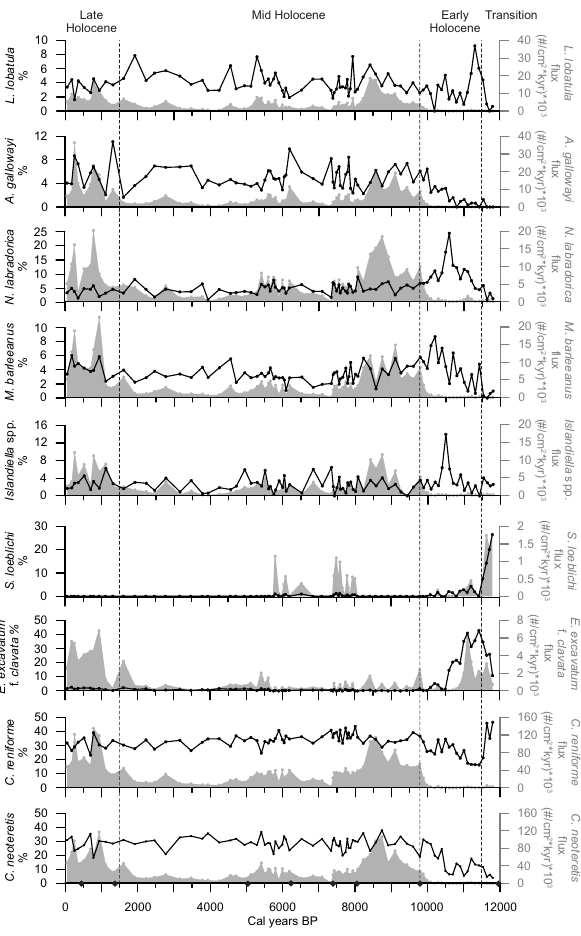
Fig. 4. Relative abundances (left, black) and fluxes (right, grey shad- ing) of the most frequent benthic foraminiferal species versus cal- endar age BP. Note the different scales. Black diamonds on x axis indicate calibrated age points.